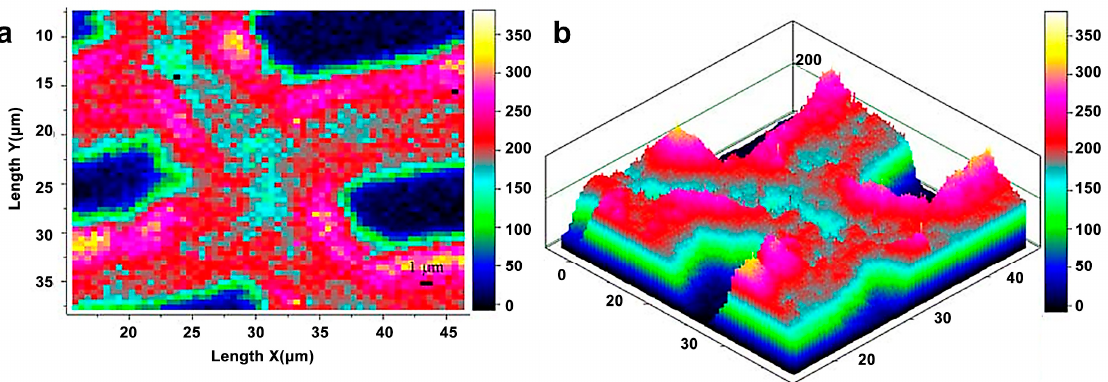
Figure 4. Raman images of cellulose spatial distribution in cell wall: two-dimensional ( a ) and three- dimensional ( b ) representations. Bright white/yellow locations indicate high cellulose concentration; dark blue/black regions indicate very low concentration, e.g., lumen area.